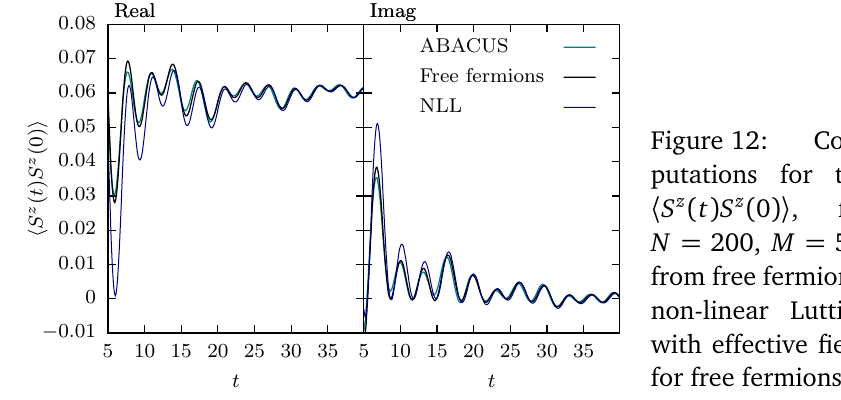
Figure 12: Comparison of com- putations for the autocorrelations 〈 S z ( t ) S z ( 0 ) 〉 , from ABACUS at N = 200, M = 50, ∆ = 1 , s = 12, 100 from free fermions ( ∆ = 0), and from non-linear Luttinger (NLL) theory with effective field parameters taken for free